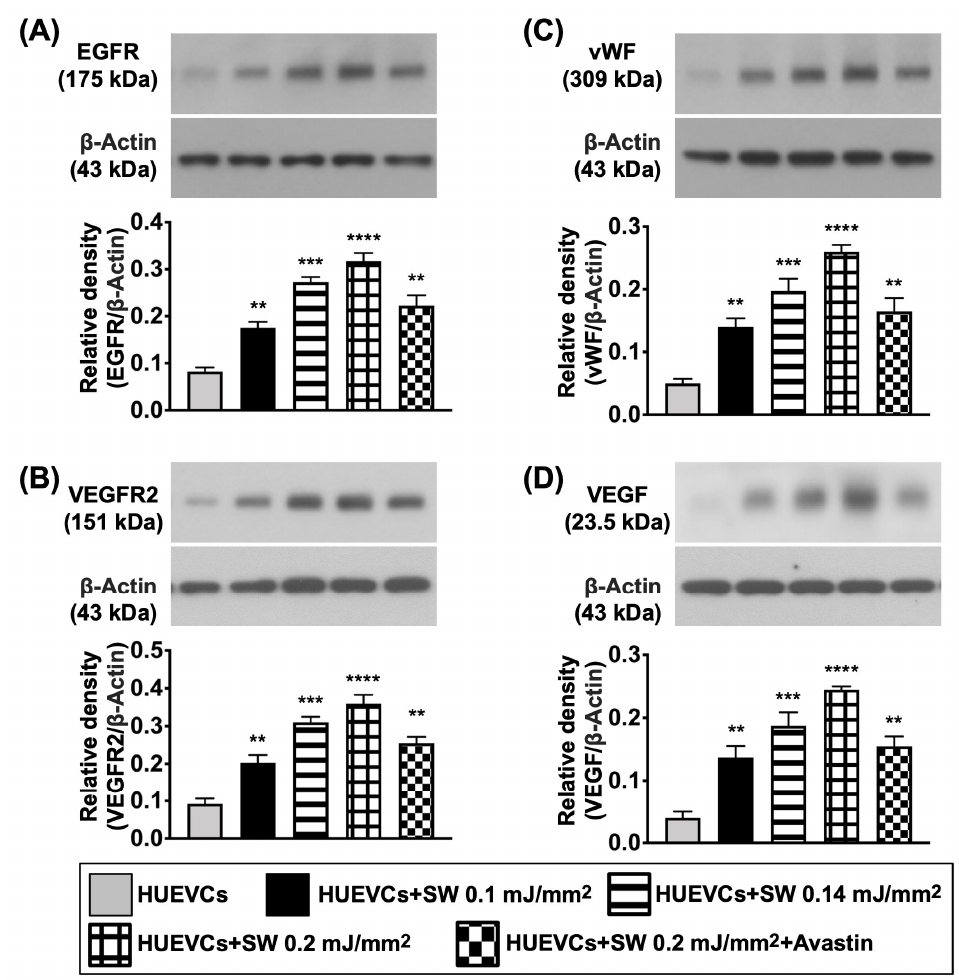
Figure 2. ECSW therapy upregulated the protein expressions of EGFR and VEGFR2, and angiogenic biomarkers in HUVECs. ( A – D ) Western blot analyses showed the results of protein expressions of epidermal growth factor receptor (EGFR) ( A ), vascular endothelial growth factor receptor 2 (VEGFR2) ( B ), von Willebrand factor (vWF) ( C ) and vascular endothelial growth factor (VEGF) ( D ). “*” represents in comparison with the control, ** for p < 0.01, *** for p < 0.001, **** for p < 0.0001. n = 4 for each group. HUVECs = human umbilical vein endothelial cells; SW = shock wave.